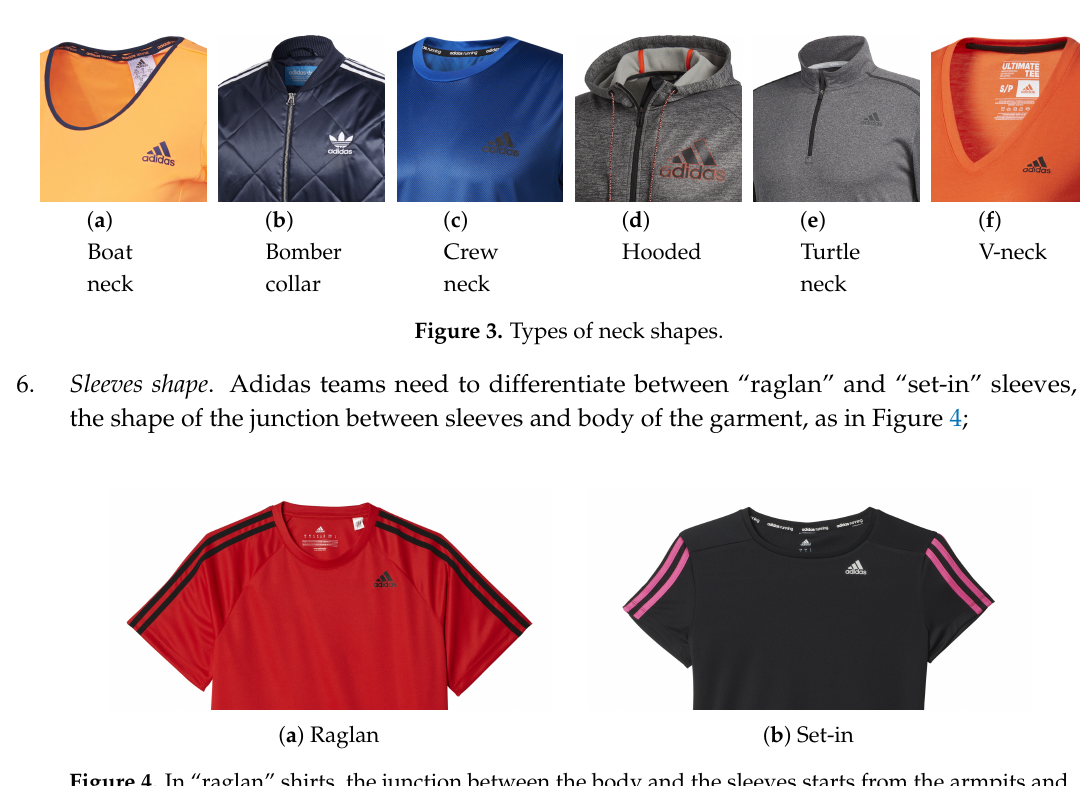
Figure 4. In “raglan” shirts, the junction between the body and the sleeves starts from the armpits and goes to the neck; the term “set-in”, instead, refers to those shirts that have the sleeves sewn with the body of the garment with a vertical